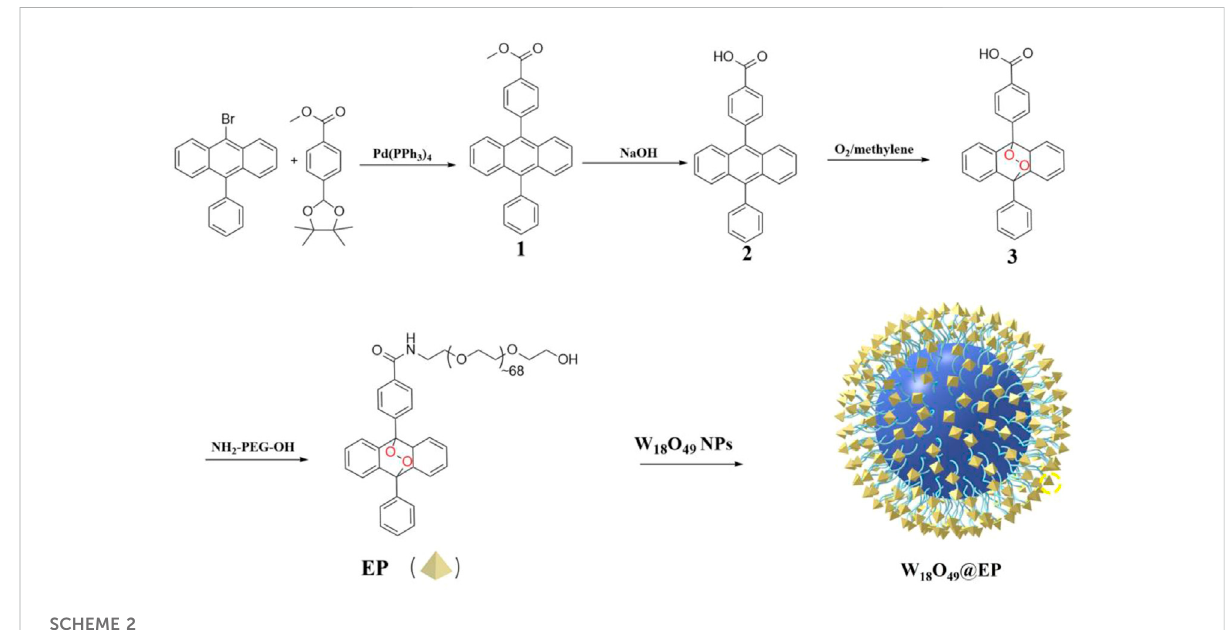
SCHEME 2 Synthetic route of W 18 O 49 @EP NPs.